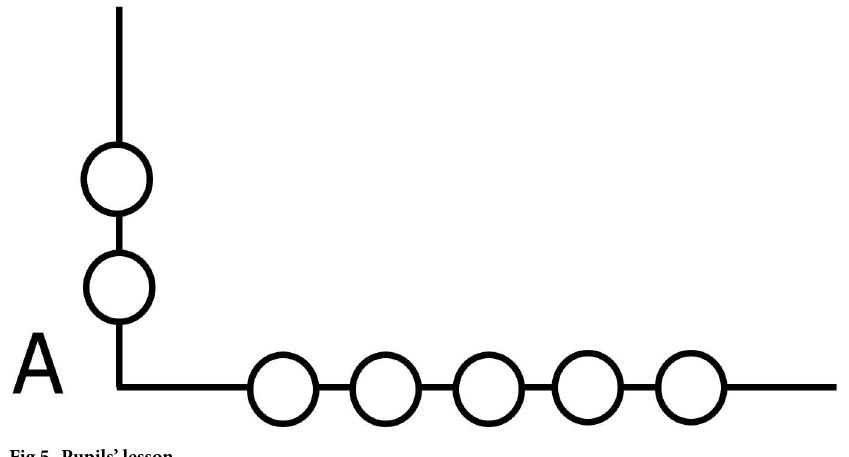
Fig 5. Pupils’ lesson.